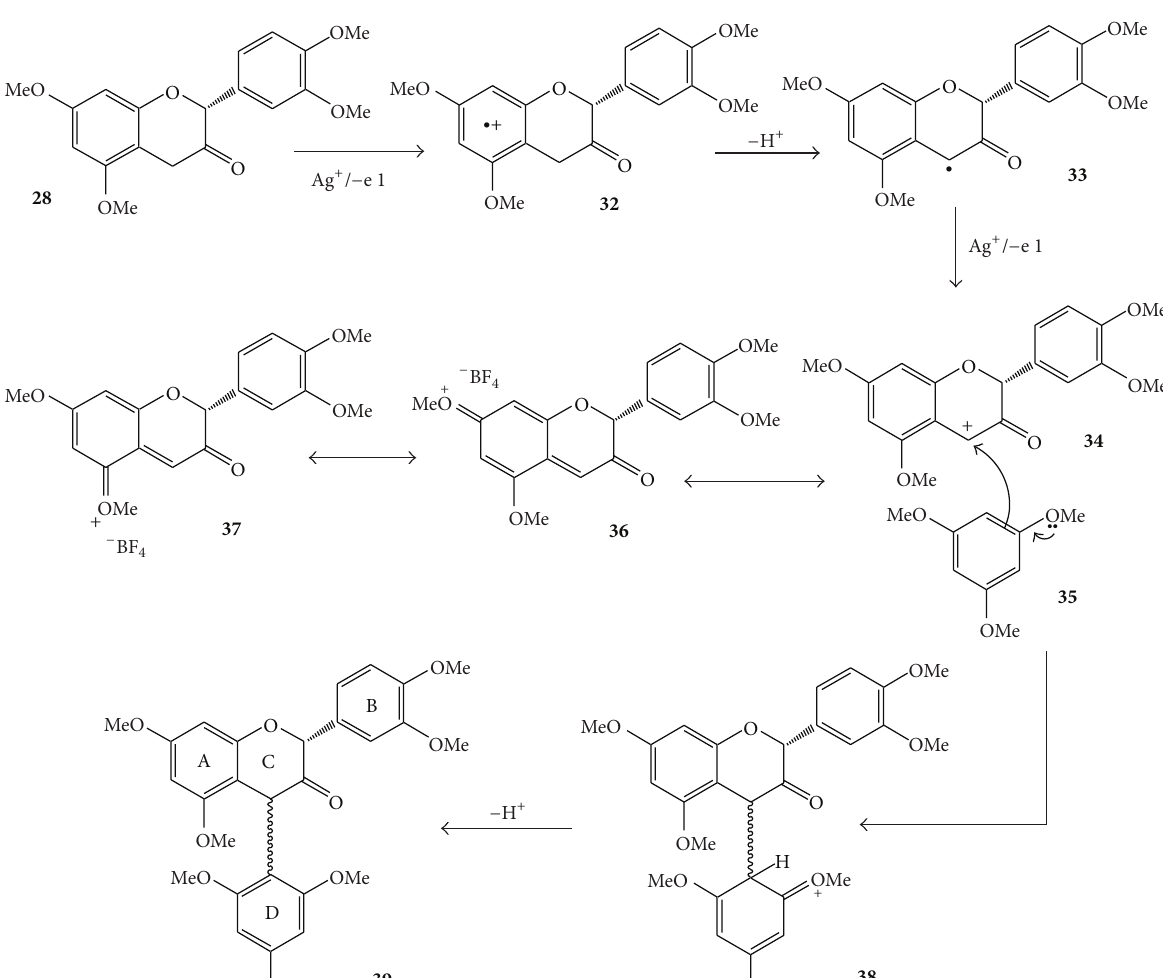
Scheme 5: Proposed mechanism for oxidative synthesis of 30 and 31 based on the model